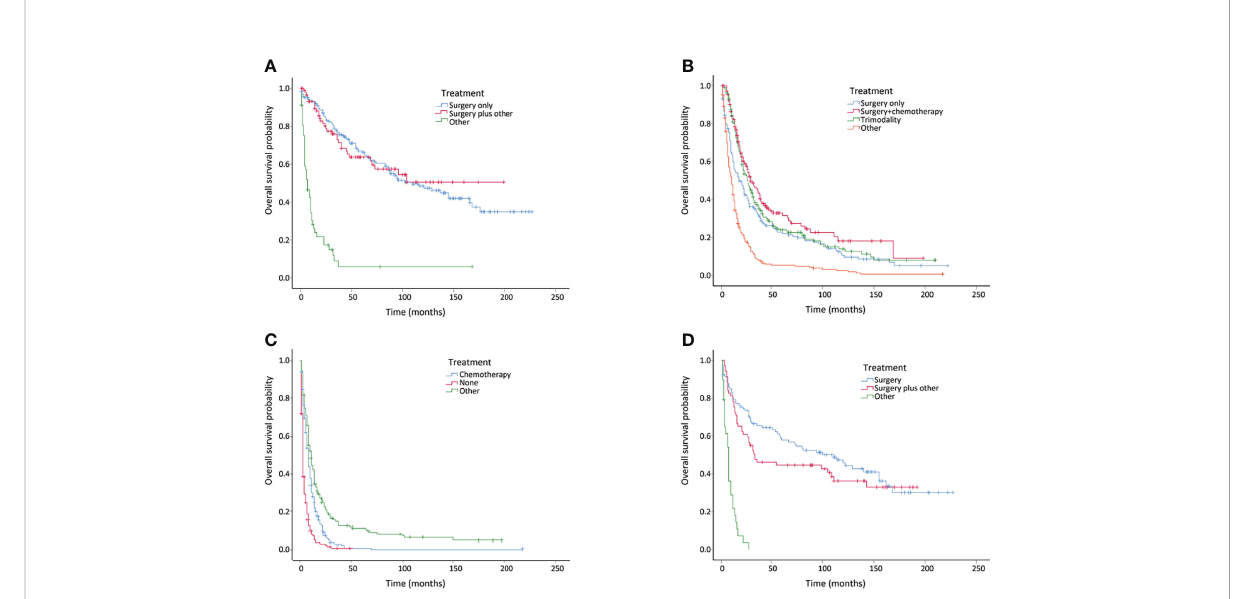
FIGURE 3 Kaplan – Meier curves of overall survival in invasive intraductal papillary mucinous neoplasm (IPMN) and invasive mucinous cystic neoplasm (MCN) patients with different treatments. (A) Invasive IPMNs with localized disease. (B) Invasive IPMNs with regional disease. (C) Invasive IPMNs with distant disease. (D) Entire invasive